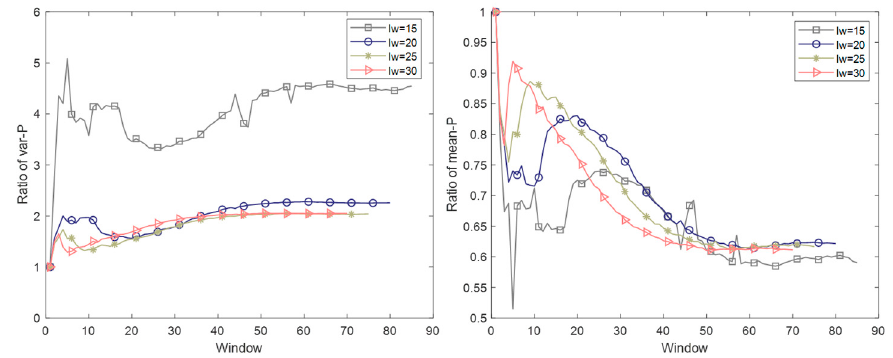
Figure 10. The variation trend of the load matrix with window length from 15 to 30.